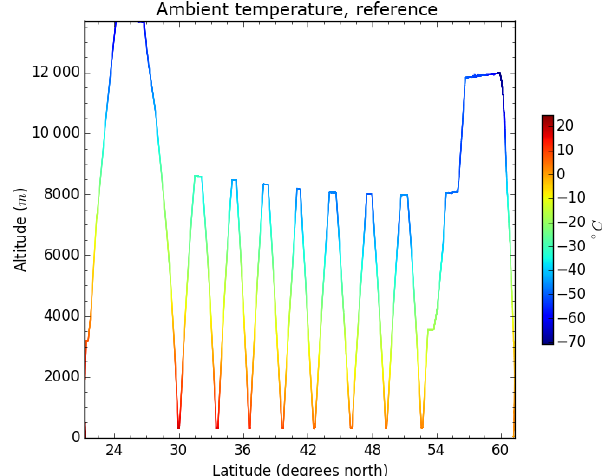
Figure 7. An example scatter plot from a particular aircraft mea- surement of ambient temperature as a function of latitude ( x axis) and altitude ( y axis) produced directly by CIS. Note the representa- tion of temperature as the colour of the scatter